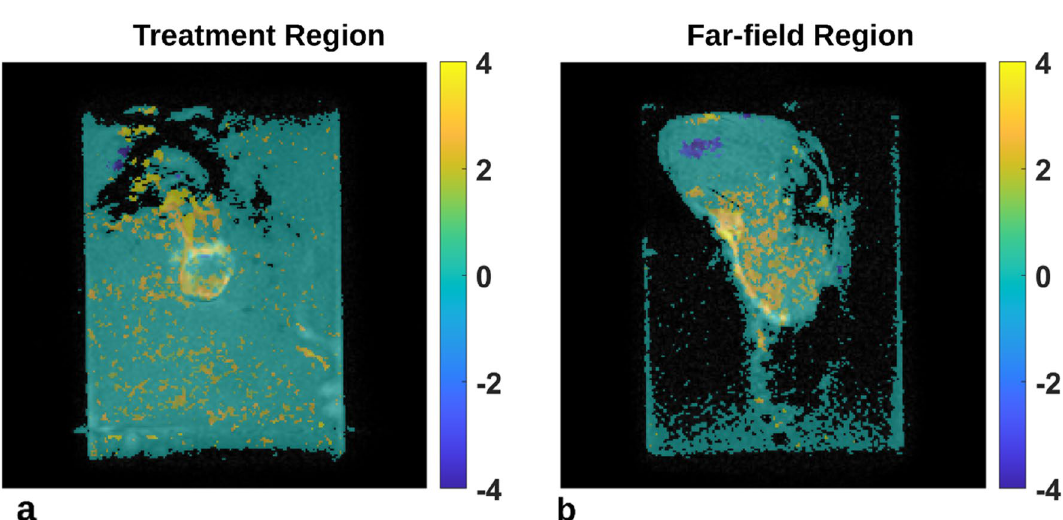
Figure 4. ( a ) Coronal plane perpendicular to the beam axis with an 18 mm treatment region (red) used to define the therapy cell on the Sonalleve and as a mask for voxel-wise temperature mapping; an off-focus region in the water bath for comparison (blue). ( b ) Coronal plane translated anteriorly 1.5 cm to define the far-field region at the tumor and muscle interface. The same treatment area is shifted to the far-field region. ( c ) Mean temperature mapping signals (n = 377 voxels in ROI) within the therapy cell (red circles) and far-field region (squares). Regression was statistically significant in both regions. Shaded areas represent 95% confidence intervals of the slope. The off-focus water region (blue diamond) was not significantly different than zero.